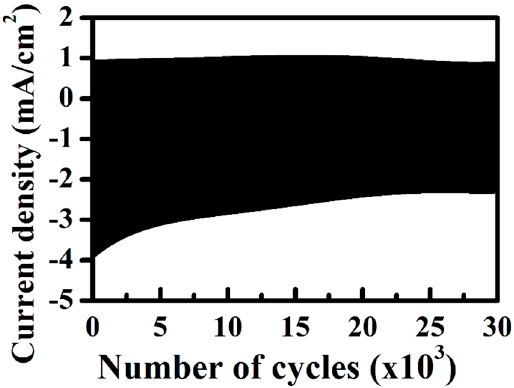
Figure 14. ( a ) Optical transmittance of the ASSECD undergoing repeated coloring and bleaching for 3 × 10 4 cycles; Photographs of the ( b ) bleached and ( c ) colored state of ASSECD after 3 × 10 4 cycles.